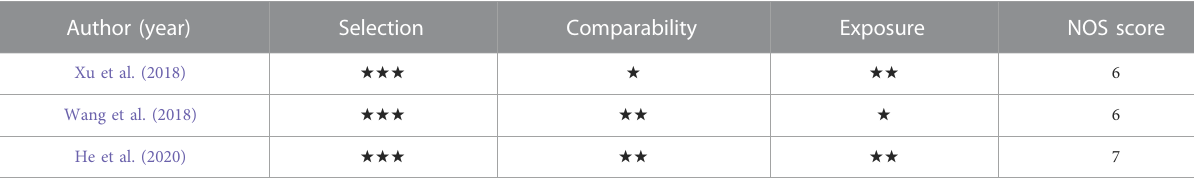
TABLE 3 Quality assessments of the controlled clinical trial and retrospective clinical studies. Author (year)